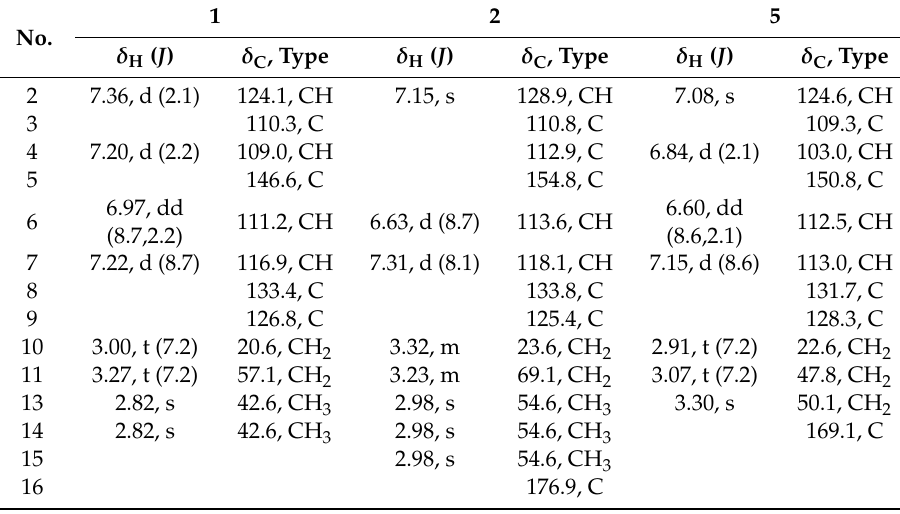
Table 1. 1 H and 13 C-NMR data (600 / 150 MHz) of compounds 1 , 2 , and 5 (1 in DMSO- d 6 , 2 in DMSO- d 6 :